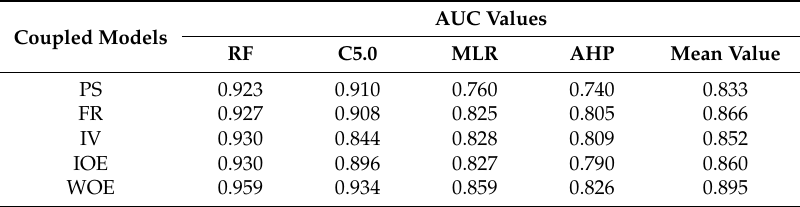
Figure 9. ROC curves of collapse modeling based on the connection methods and data-based models: ( a ) AHP, ( b ) MLR, ( c ) C5.0 and ( d ) RF models. ( a ) AHP, ( b ) MLR, ( c ) C5.0 and ( d ) RF models. Table 4. Area under the ROC curve (AUC) values of di ff erent connection methods under di ff erent Table 4. Area under the ROC curve (AUC) values of different connection methods under different data-based data-based models.